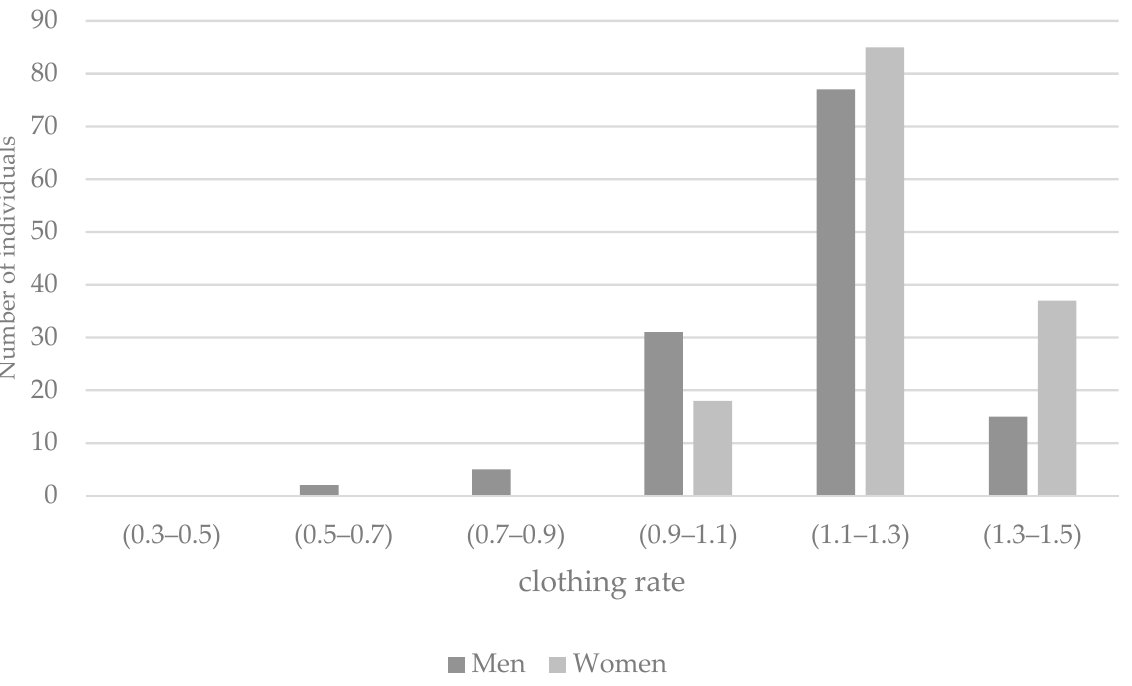
Figure 11. In cold seasons clothing range for women and men is the same because both genders do not have a limit about increasing their clothing rate.